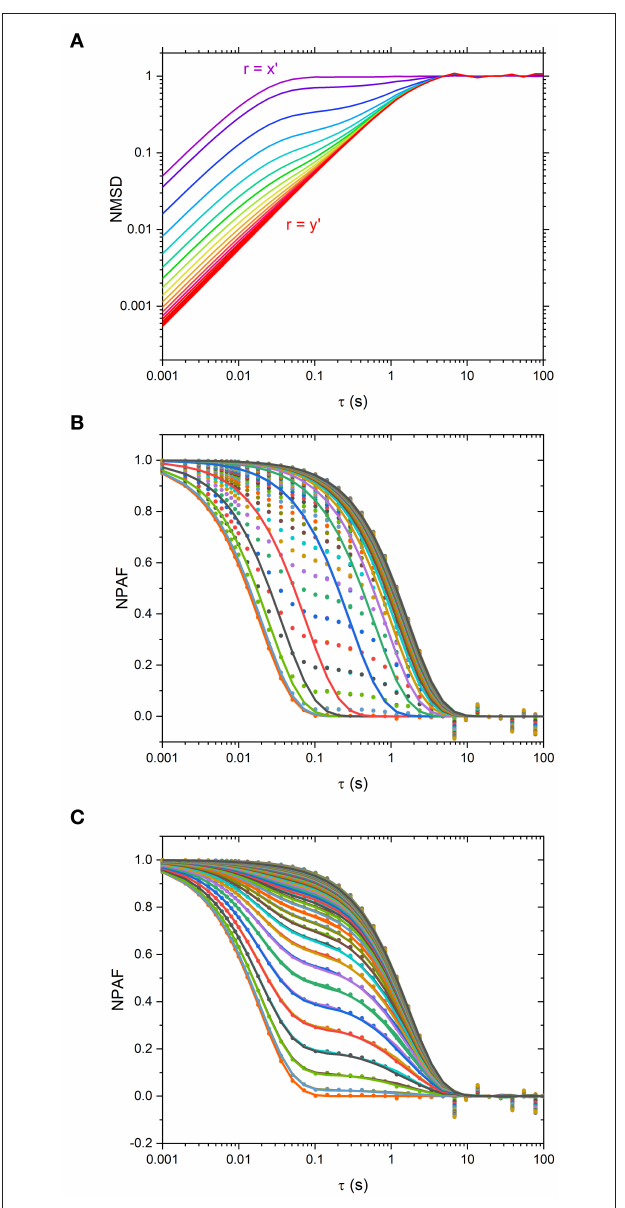
FIGURE 3 | (A) Normalized mean squared displacement (NMSD) simulated data plotted at 1 θ = 5 ◦ intervals from θ - φ = 0 o (purple, r = x’ axis) to θ − φ = 90 o (red, r = y’ axis). Traces are colored such that purple traces are aligned along x’ and red aligned along y’. (B) Normalized Position Autocorrelation Function (NPAF) simulated data (dots) and fits to equation 1, the mono-exponential expression for NPAF, plotted at 1 θ = 1 ◦ intervals (lines). (C) the same as in (B) but with fits to the multi-exponential expression for NPAF, Equation 15.